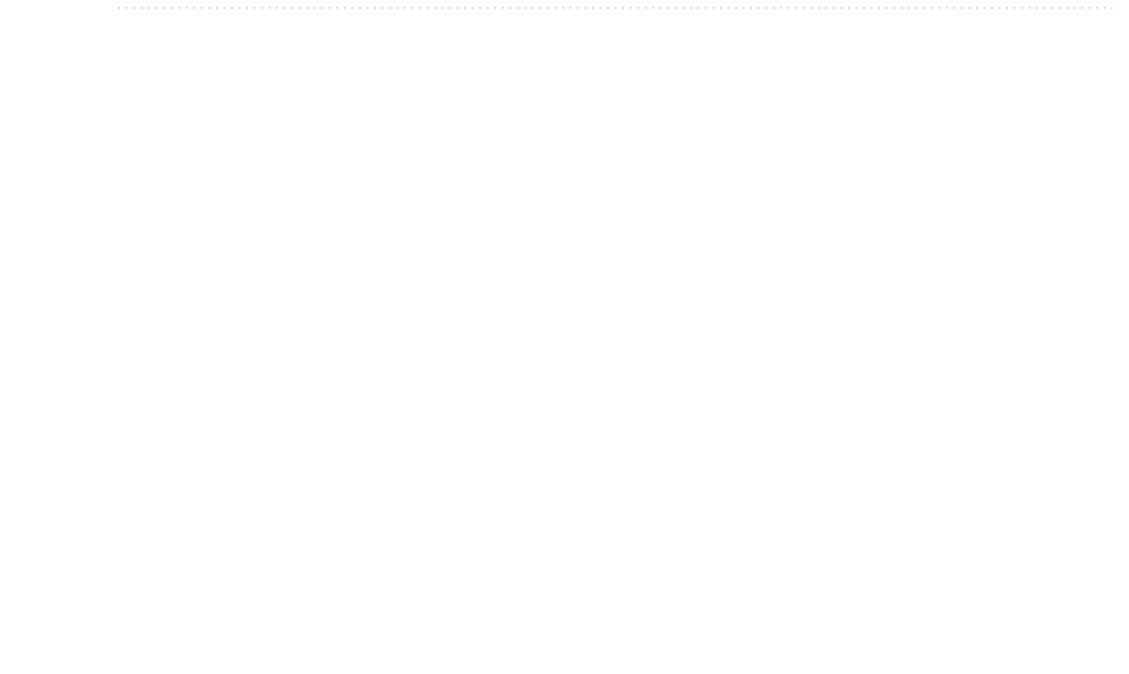
Figure 6. TEM images of UiO-66-NH 2 ( a , b ); and UiO-66-biguanidine/Pd nanocomposite ( c , d